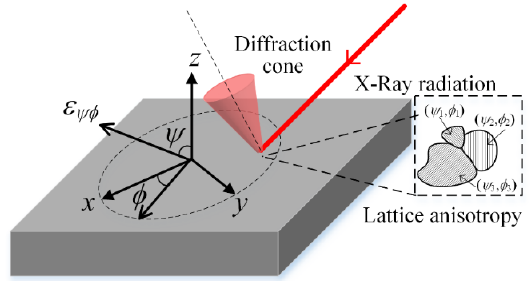
Figure 3. Scheme of residual stress detection by X-ray diffraction.